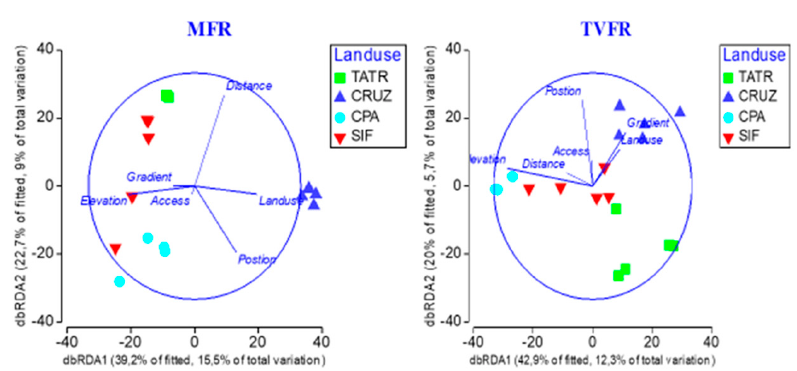
Figure 7. db RDA (Distance-based redundancy analysis) graphs on the relationship of land use regimes (based on land use intensity gradient) and other change drivers to overall β -diversity. MFR = Mafhela Forest Reserve, TVFR = Thathe Vondo Forest Reserve; TATR = Trees along rivers and streams, CRUZ = Common resource use zone, CPA = Culturally protected forests, SIF = State-protected indigenous forest.